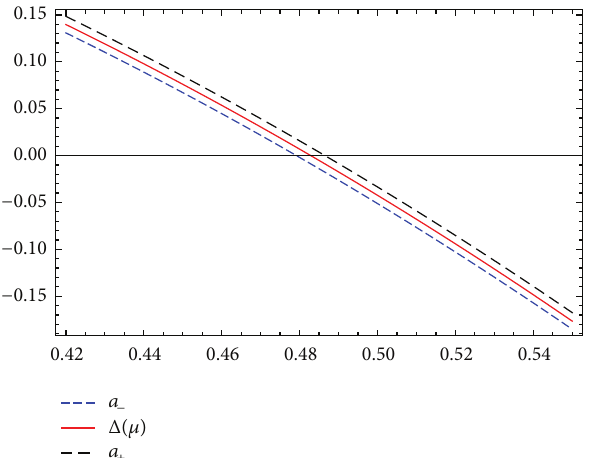
Figure 5: The enclosure interval dominating 𝜇 1 for 𝑚 = 14 , 𝑁 = 40 , 𝜃 = 1/26 , and 𝜀 = 10 −5 .